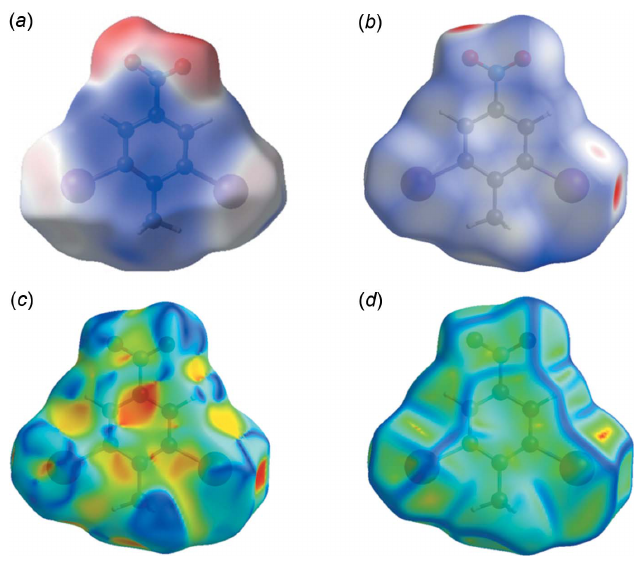
Figure 7 Hirshfeld surface for DINT mapped over ( a ) calculated electrostatic potential, ( b ) d norm , ( c ) shape-index and ( d ) curvedness.